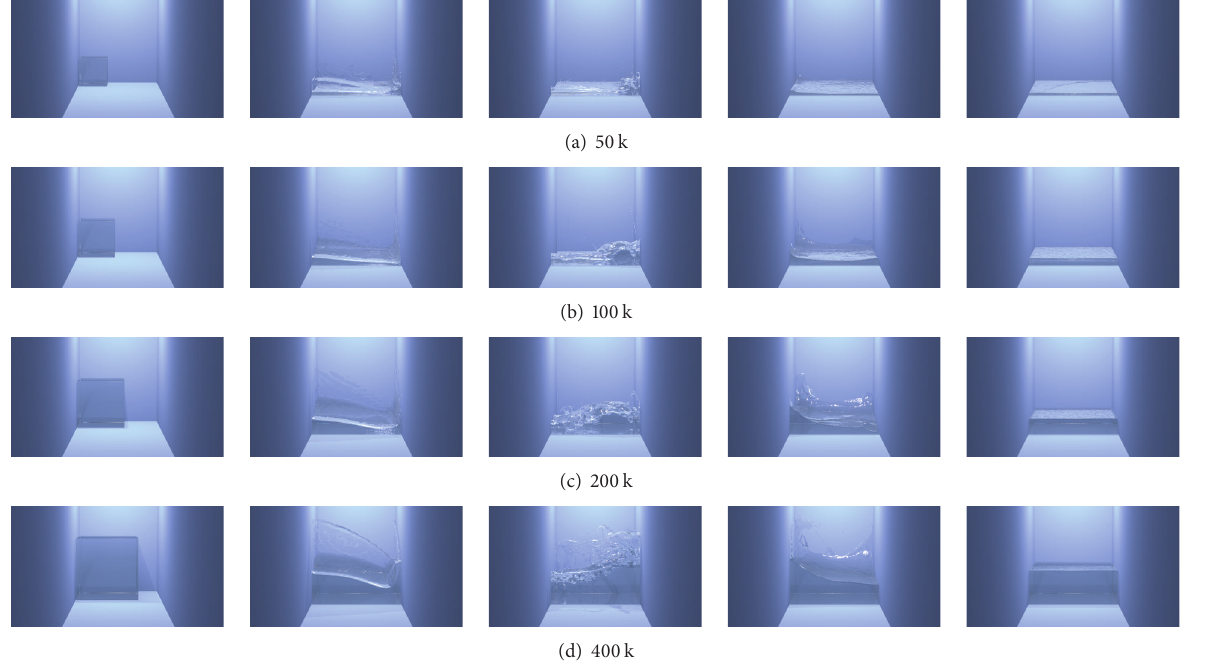
Figure 5: Corner dam break using (a) 50 k, (b) 100k, (c) 200 k, and (d) 400k fluid particles, respectively. This example shows that the greater the proportion of nonsleepy particles is, the larger the speed up can be